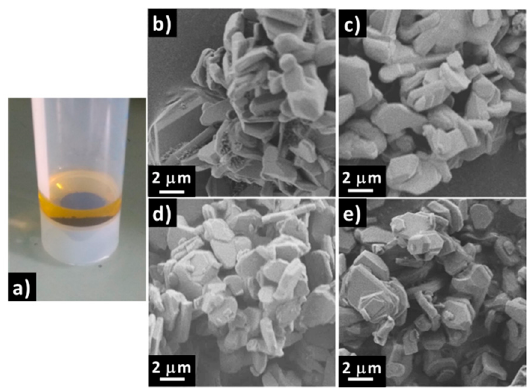
Figure 1. ( a ) Picture of P2-Na 0.67 Mn 0.6 Fe 0.25 Co 0.15 O 2 (NaMFC) powder immersed in water showing the yellowish coloration; SEM pictures of ( b ) pristine NaMFC, ( c ) NaMFC_5 min immersed in water, ( d ) NaMFC_stirred in water and ( e ) NaMFC_1 day immersed in water.